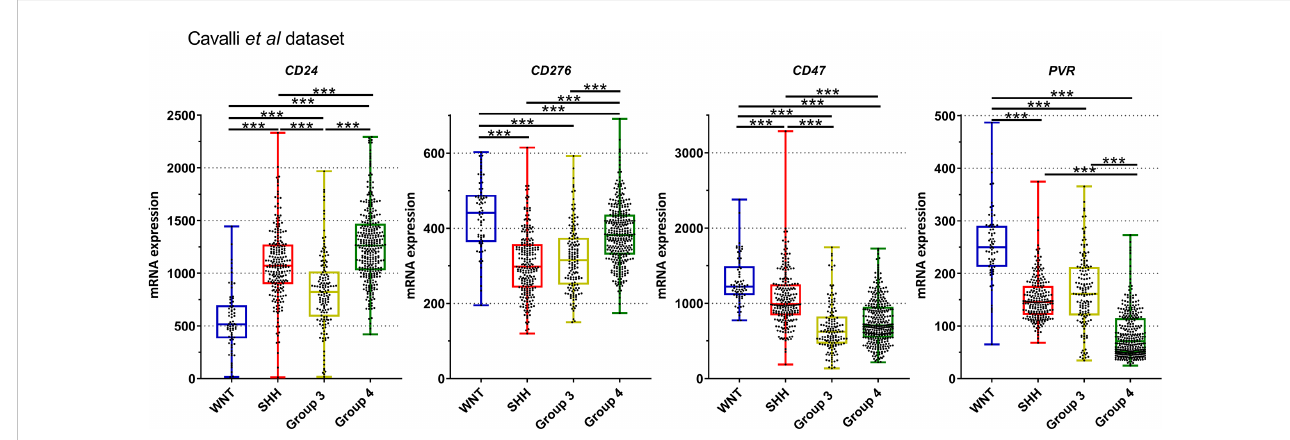
FIGURE 6 Graphic representation of CD24 , CD276 , CD47 , and PVR mRNA normalized mRNA levels obtained from Cavalli et al. dataset. The signi fi cance level is 0.05. * < 0.05, ** < 0.01, *** < 0.001. The plots were obtained through GraphPad Prism